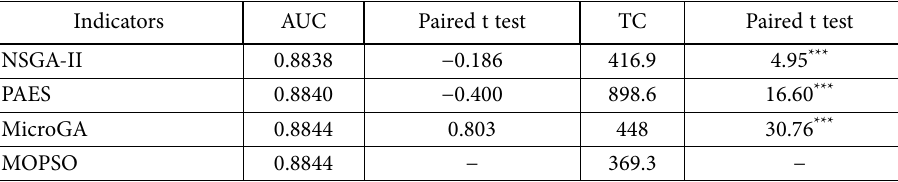
Table 8. Experimental results of performance